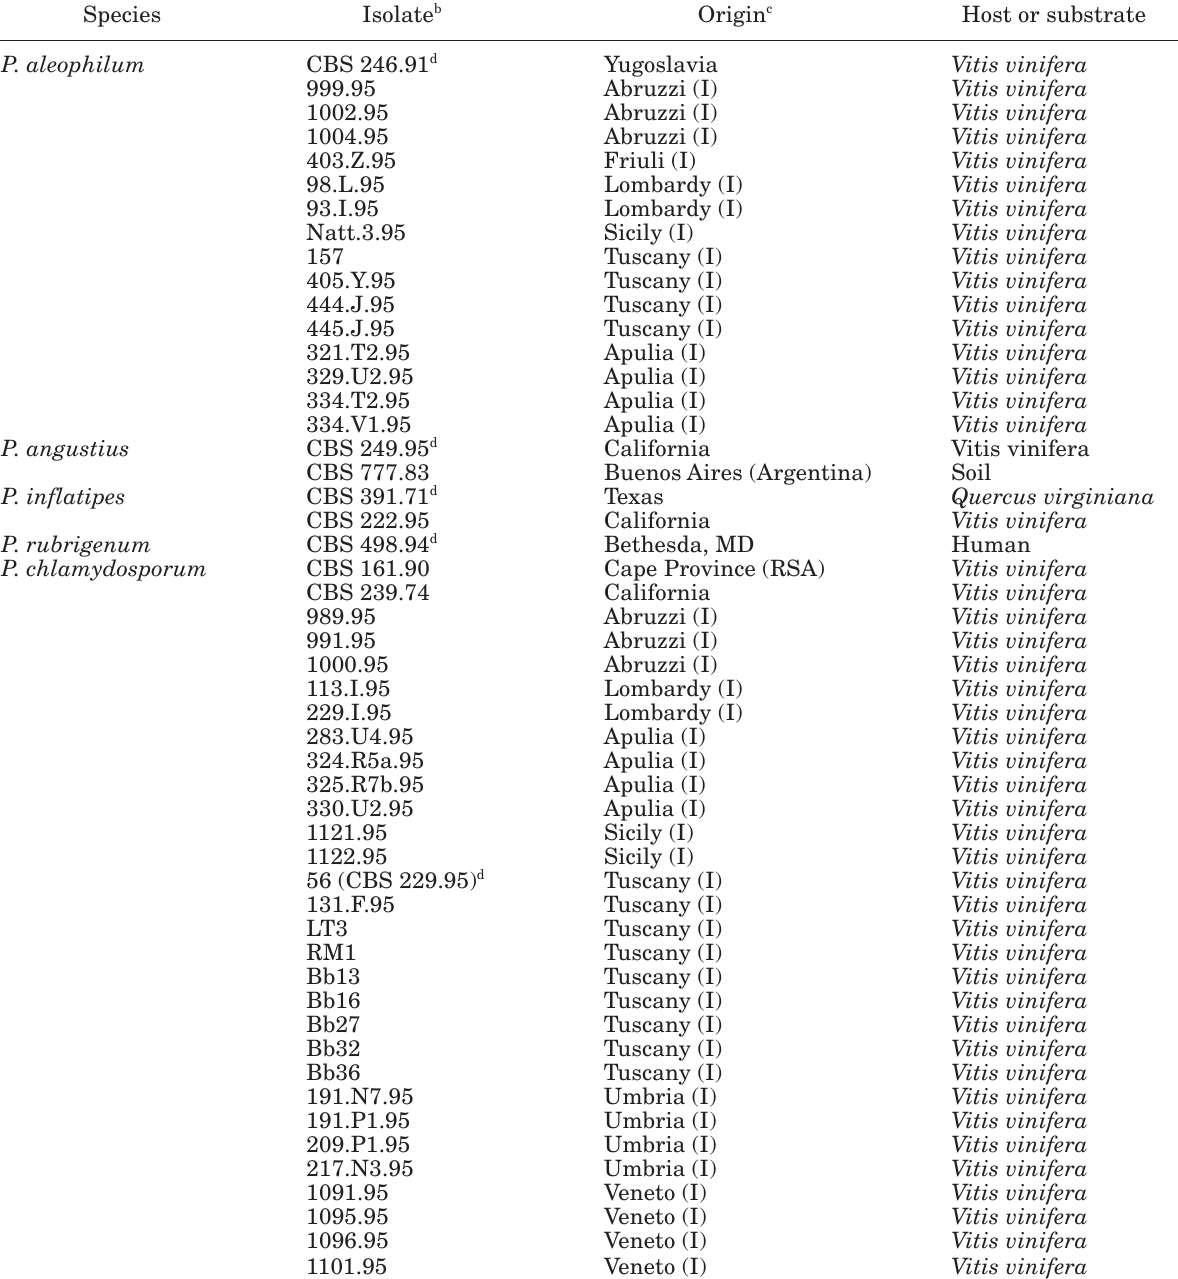
Table 1. Isolate designation, geographic origin and host or substrate of Phaeoacremonium spp. used in this study. a